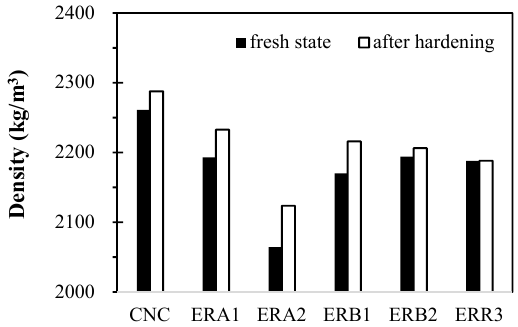
Figure 5. Test values of density by different mix design methods.